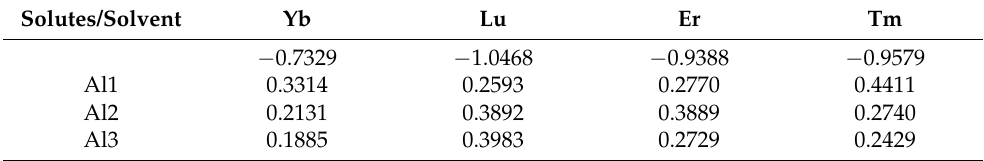
Table 2. The calculated charge transfer numbers caused by solute atoms in the L1 2 -Al 3 M structures.